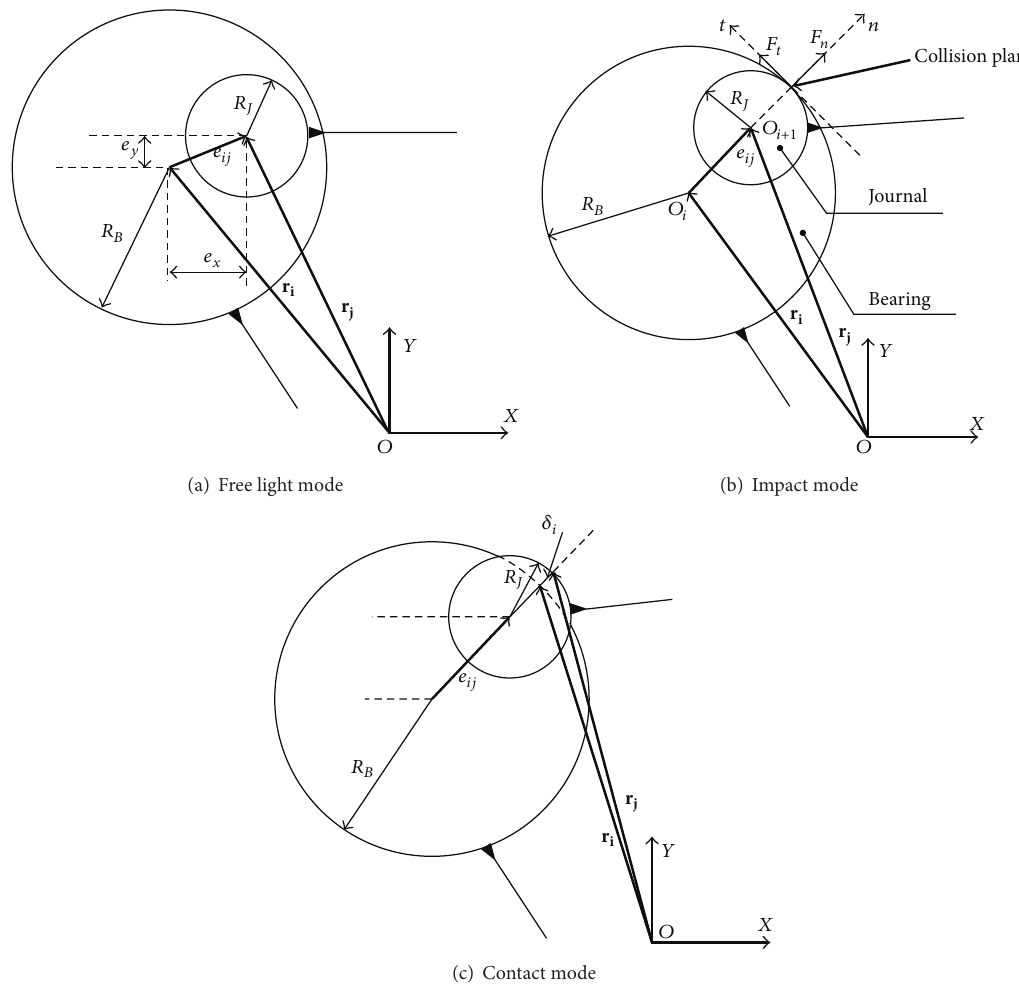
Figure 4: Realistic revolute joint with clearance.